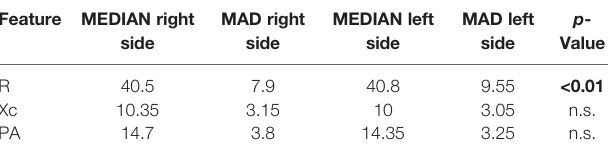
The last column shows the results of the Wilcoxon signed-rank test between the left and right sides of the prostate (n.s., nonsigni fi cant p-value). Bold values indicate signi fi cant p-values lower than 0.05.